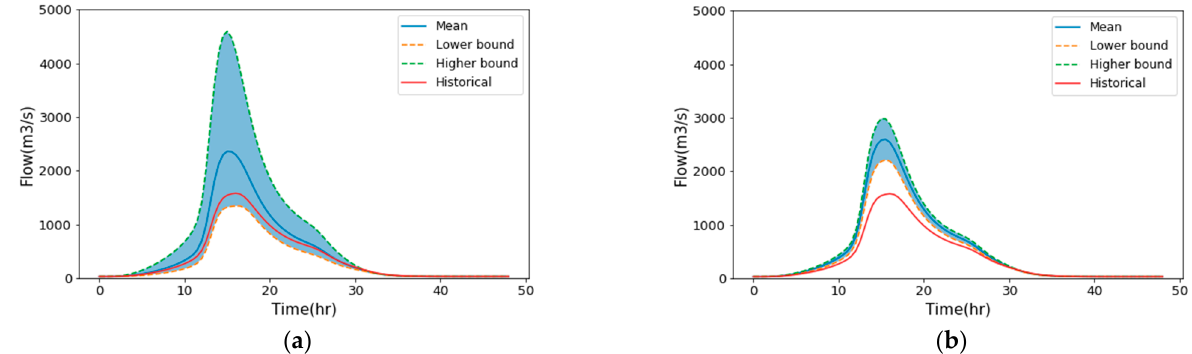
Figure 7. Flow hydrographs at the gauge of Harry’s River below the Highway Bridge for a 100-year event corresponding to the historical and future (2080s, RCP8.5) periods. Hyetographs are generated based on ( a ) GCM-IDFs and ABM method, and ( b ) WRF-IDFs and ABM2 method. The lower and higher bounds represent the minimum and maximum values of six GCMs.